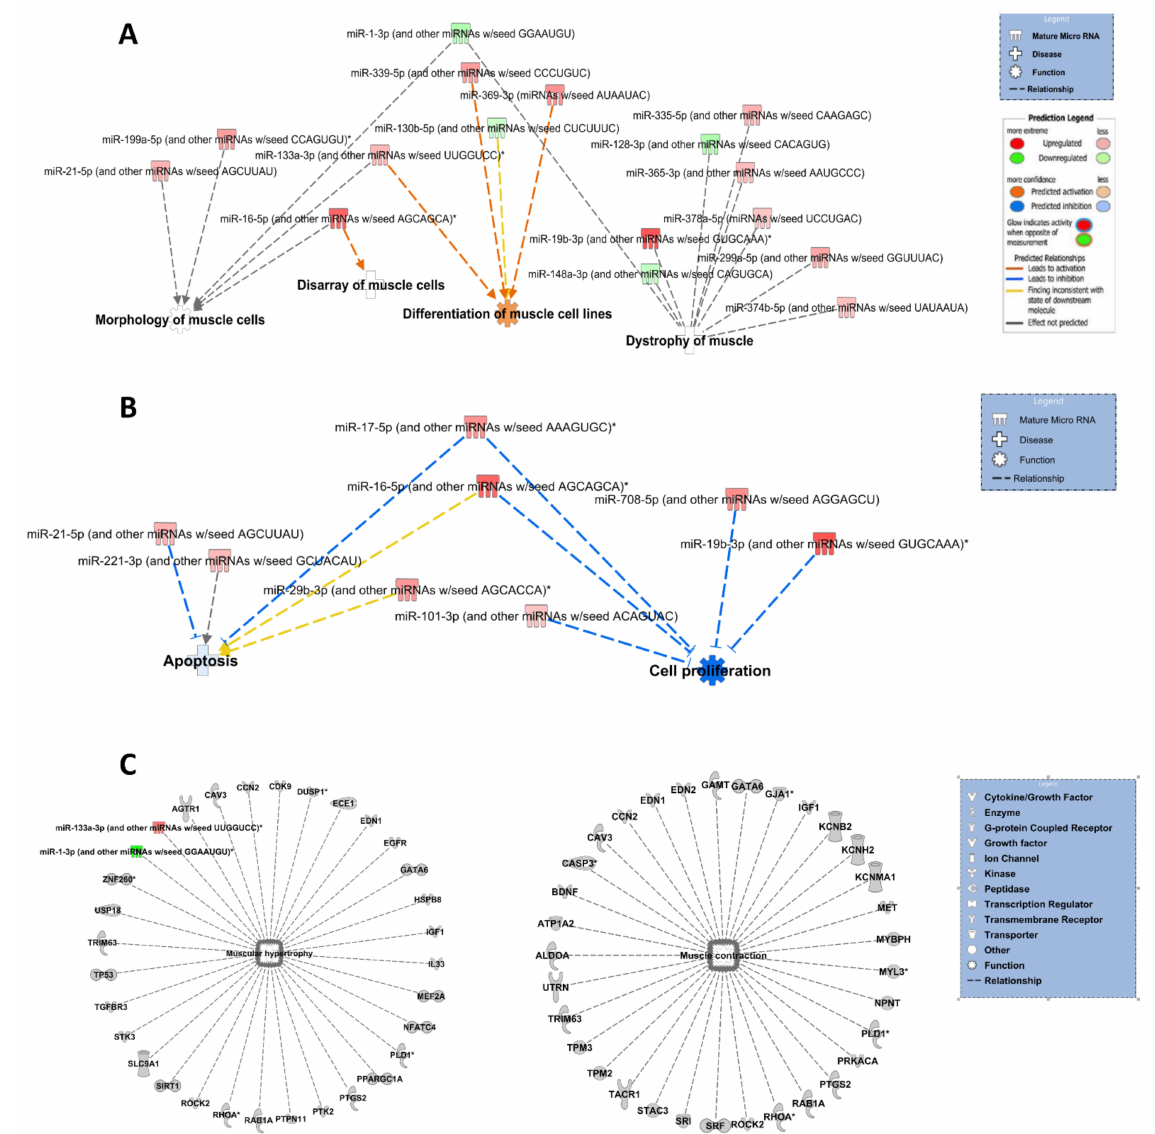
Figure 3. Bioinformatic analyses of differentially expressed miRs. Ingenuity Pathway Analysis representation of functions using DE miRs between NN/LN and NL male groups. Differentiation, morphology and disarray of muscle cells were identified by IPA as the predominant cellular functions and dystrophy of muscle as the most relevant disease which were correlated with the 92 differentially expressed miRs ( A ). Top GO terms identified in miR IPA core analysis were apoptosis and cell proliferation which relate to specific miRs ( B ). Muscle hypertrophy and contraction were the top GO terms associated with predicted gene targets of DE miRs ( C ). Figures are graphical representations of miRs identified in our data in their respective networks. Red nodes correspond to upregulated gene expression in NN/LN, and green nodes downregulation. Intensity of colour is related to higher fold-change. Legends to the main features in the networks are shown. The function colour is dependent on whether it is predicted to be activated or